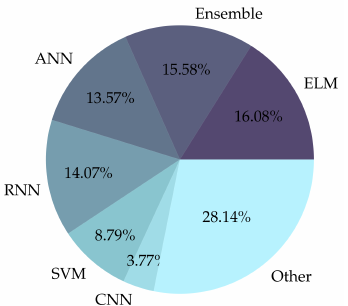
Figure 5. Top ML methods used in anayzed